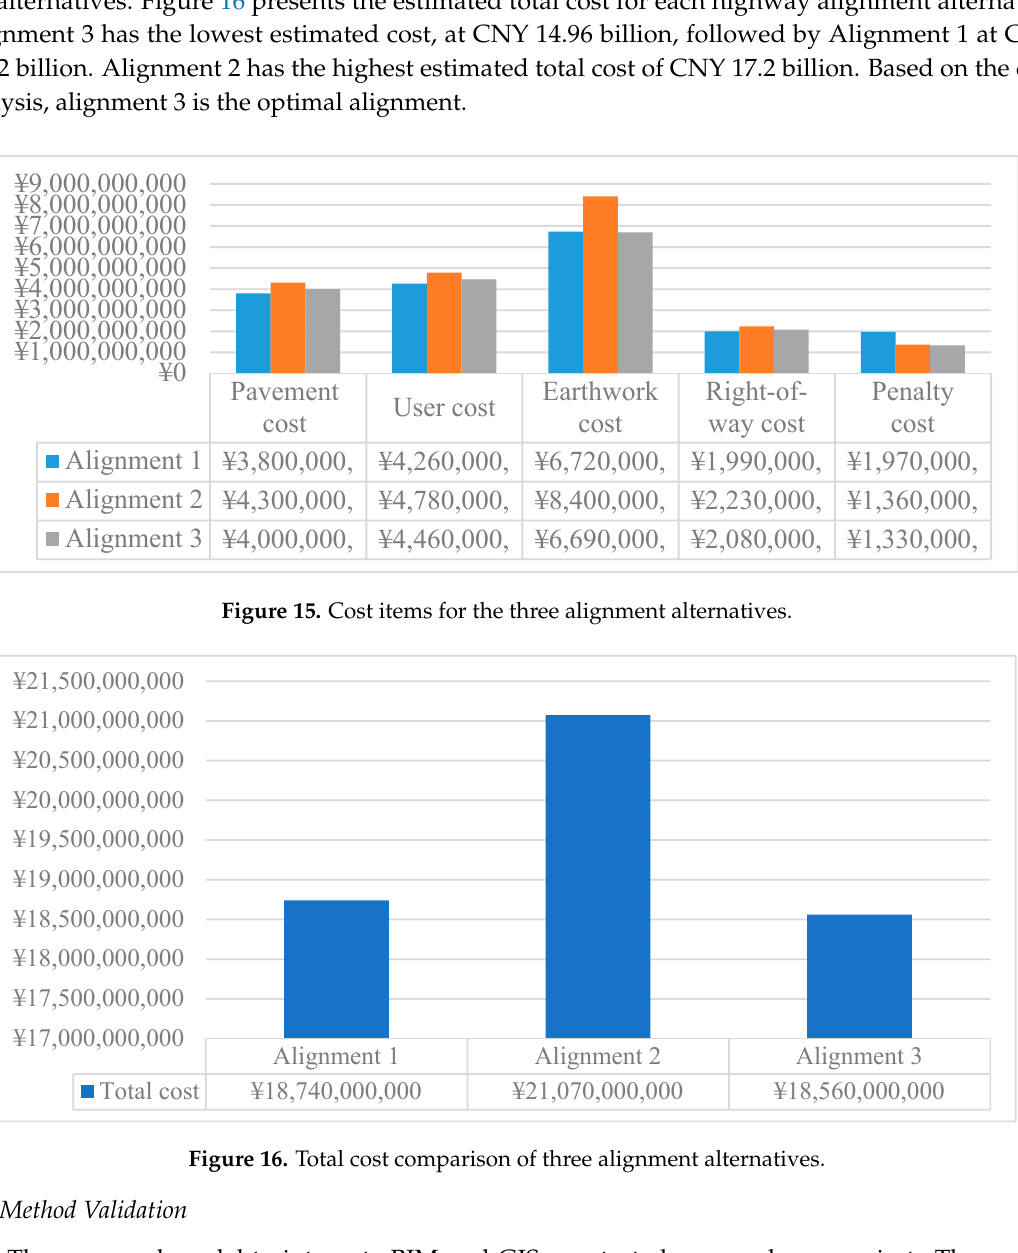
Figure 17. ( a ) The project in BIM environment; ( b ) the overview of the project in the integrated system; ( c ) the enlarged section (the squared part in ( b )) of the project in the integrated system.